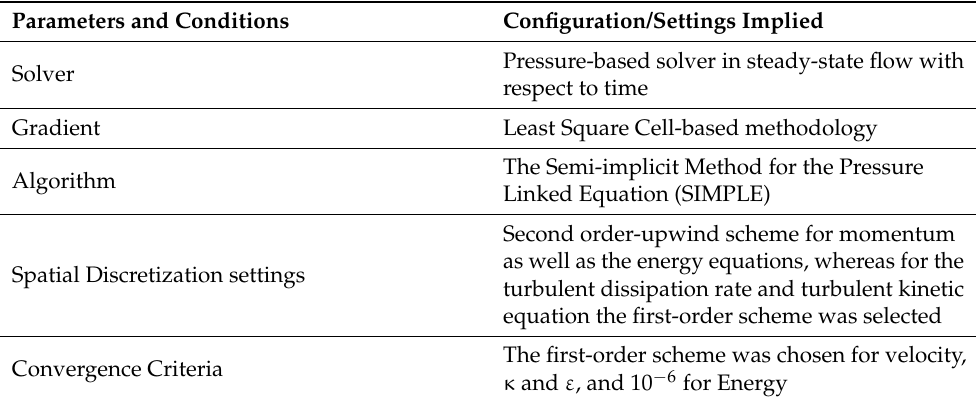
Table 4. Conditions and parameters for numerical simulations.